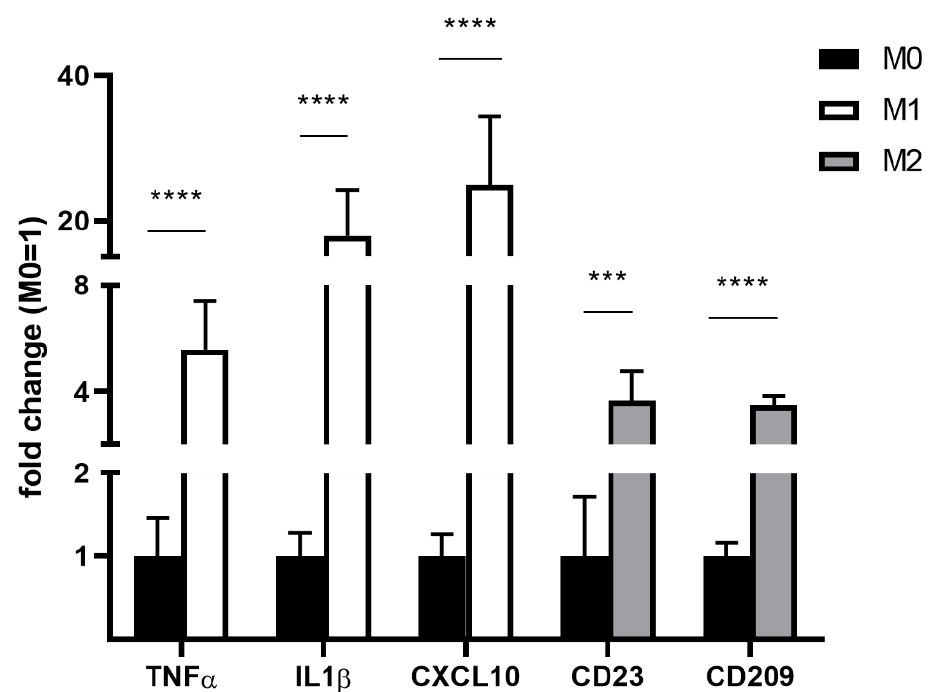
Figure 6. Expression of M1/M2 markers in differently polarized THP-1 macrophages as determined via RT-qPCR. Gene expression was expressed relative to beta-actin housekeeping gene expression and to resting M0 macrophages. Measurements were performed from n = 3 and as triplicates. Sta-